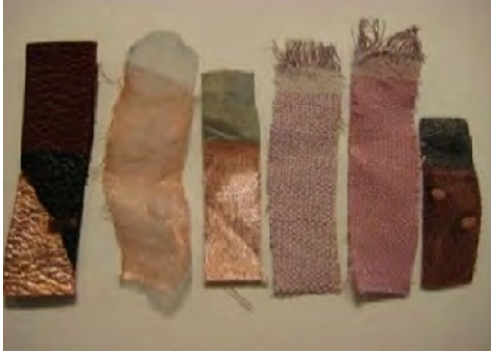
Figure 3. Different textile conductive materials for flexible antennas. Reprinted from ref. [15] .